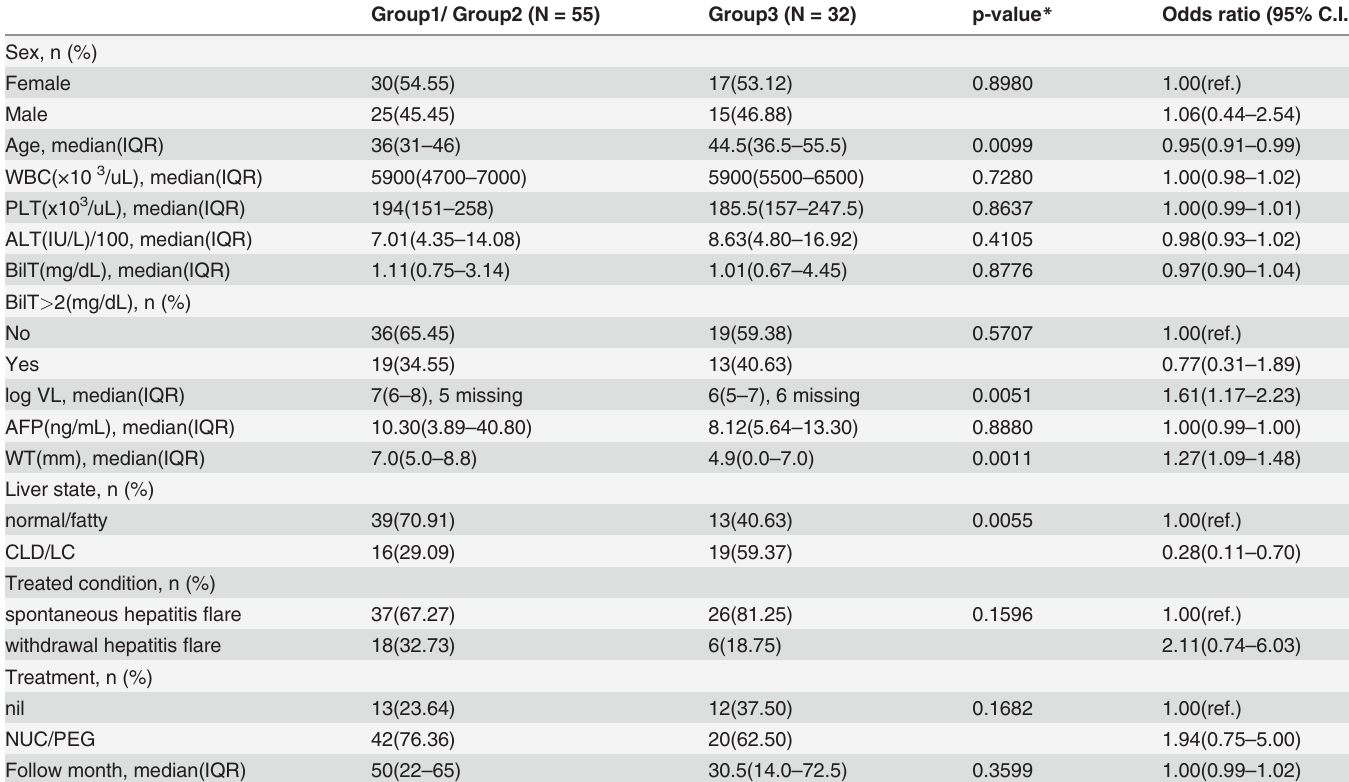
Table 2. Distribution for CHB w AE eAg+ vs. CHB w AE eAg- including the results of nodal widths. Group1/ Group2 (N = 55)